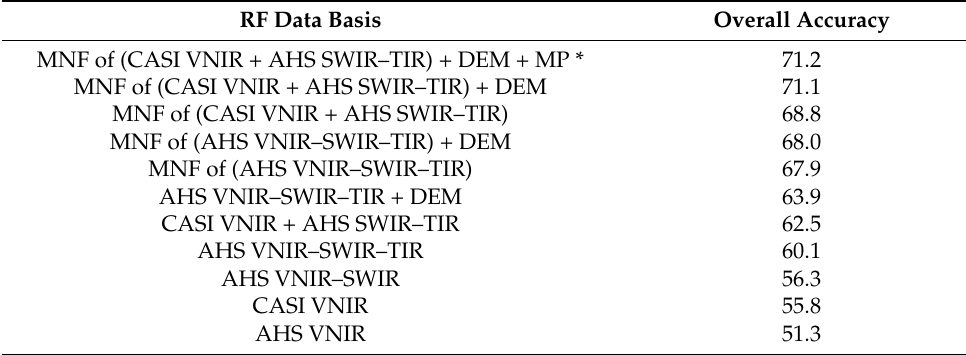
Table 4. Performance of RF classification of SEAS using different sets of covariates.